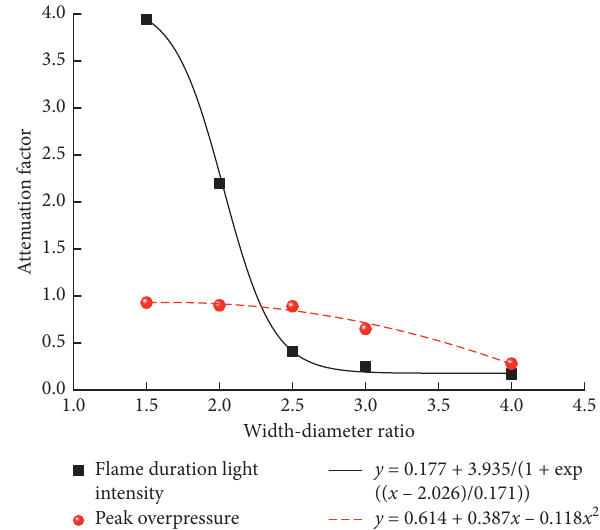
Figure 13: Quantitative relation of width-diameter ratio to gas explosion wave